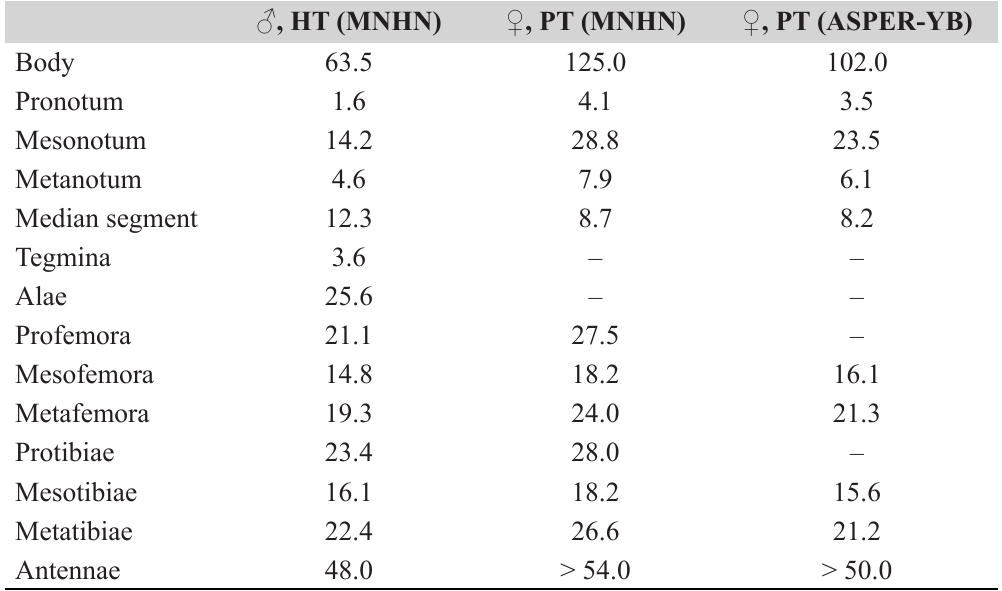
Table 4 . Measurements of Phantasca guianensis sp. nov. (in mm). HT = Holotype; PT = Paratype. ♂ , HT